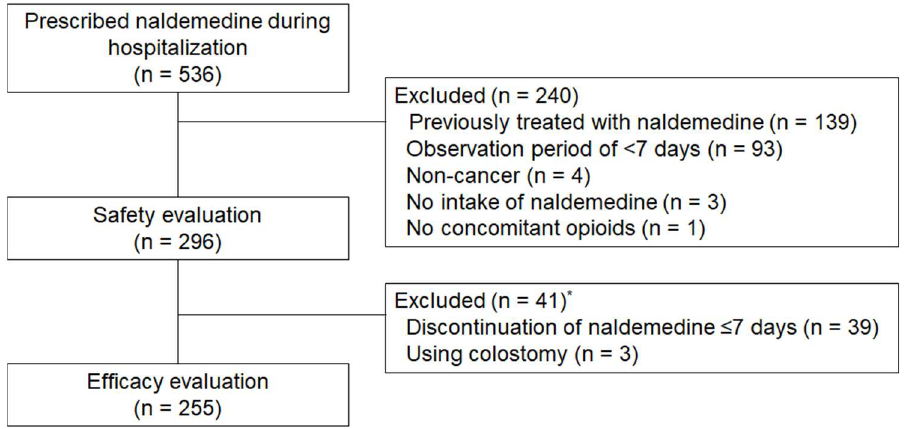
Figure 1. Flow diagram of patient enrollment. * One patient who had a colostomy discontinued naldemedine on day